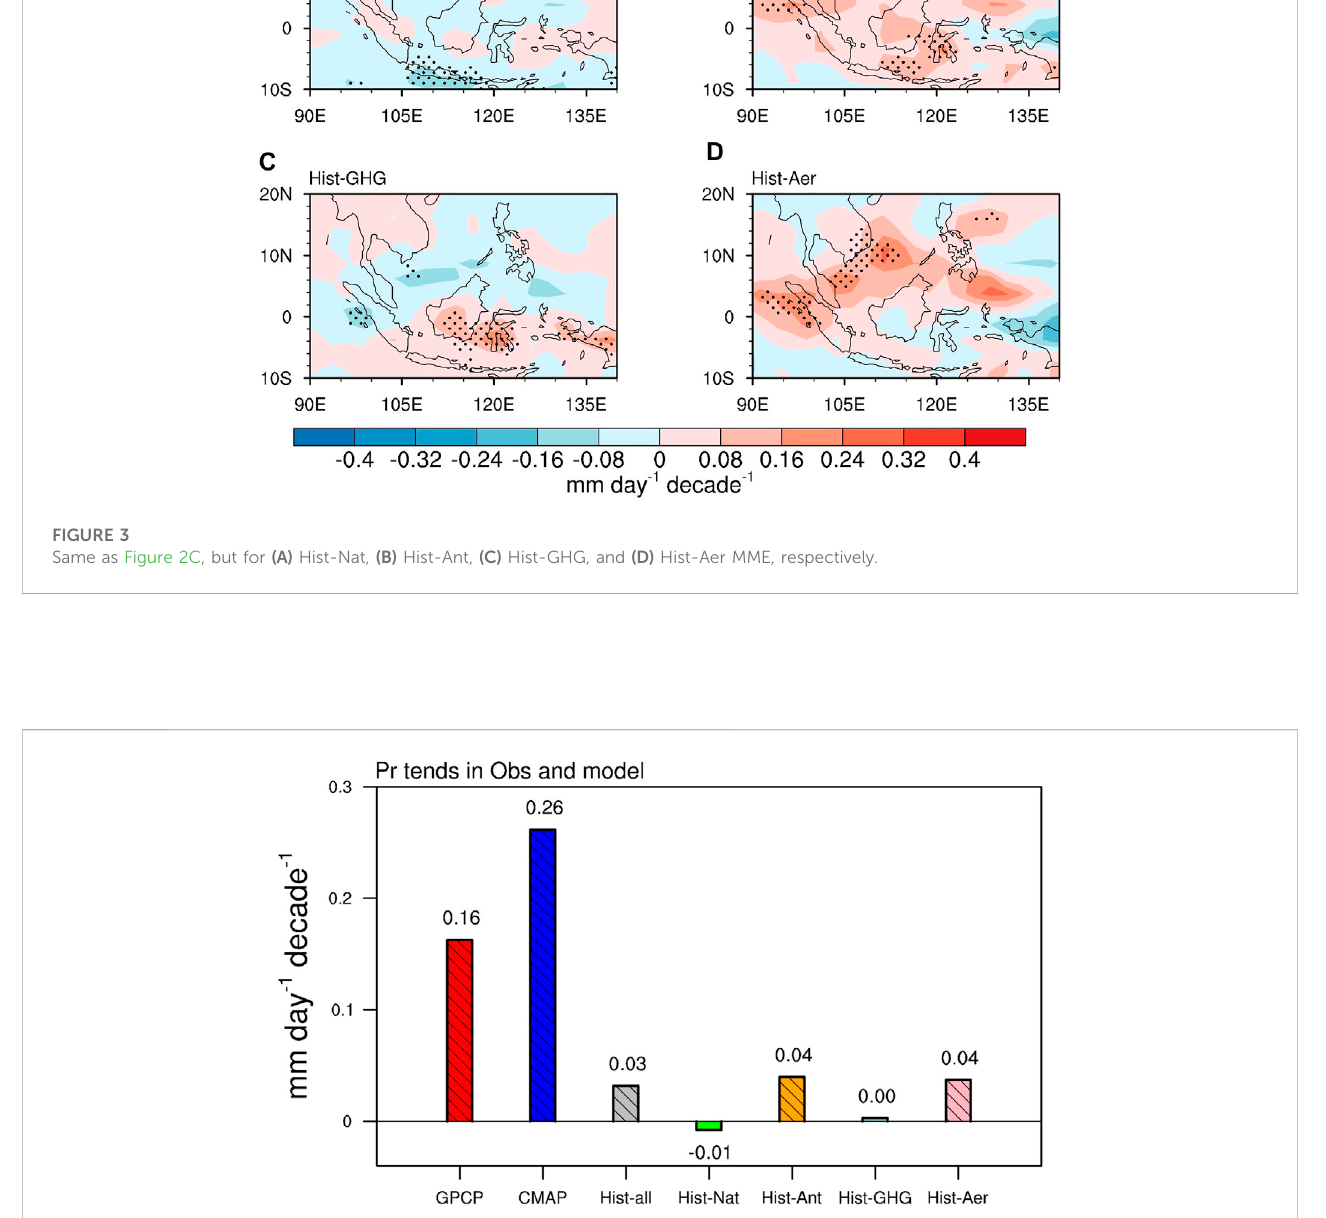
FIGURE 4 Linear trends of winter precipitation (unit: mm day − 1 decade − 1 ) averaged over Southeast Asia (10 ° S – 20 ° N, 90 ° – 140 ° E) from 1979 to 2014 in GPCP (red), CMAP (blue), Hist-all (gray), Hist-Nat (green), Hist-Ant (orange), Hist-GHG (light-blue), and Hist-Aer (pink) MME, respectively. The inner numbers indicate the corresponding trends. The oblique line indicates the difference between the area-mean trend and zero exceeding the 90% con fi dence level based on the single sample t